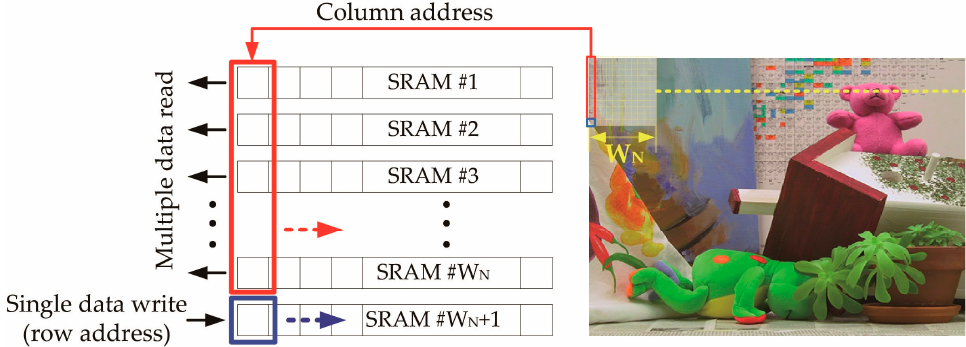
Figure 3. Illustration of the multiple-read, single-write operation of the stereo matching algorithm.